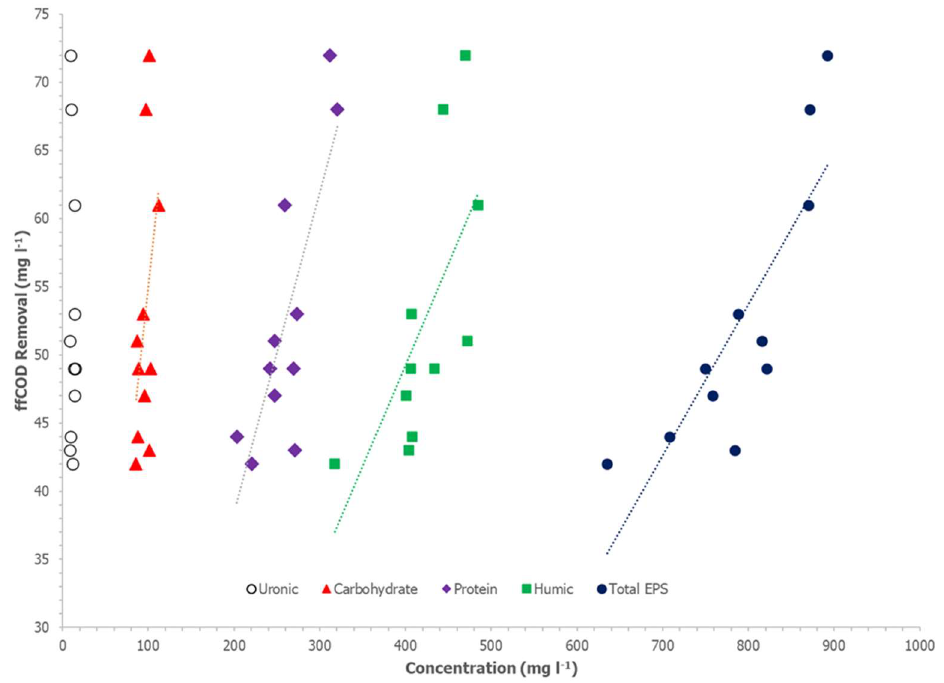
Figure 4. Biosorption of ffCOD as a function of EPS Component Concentrations.